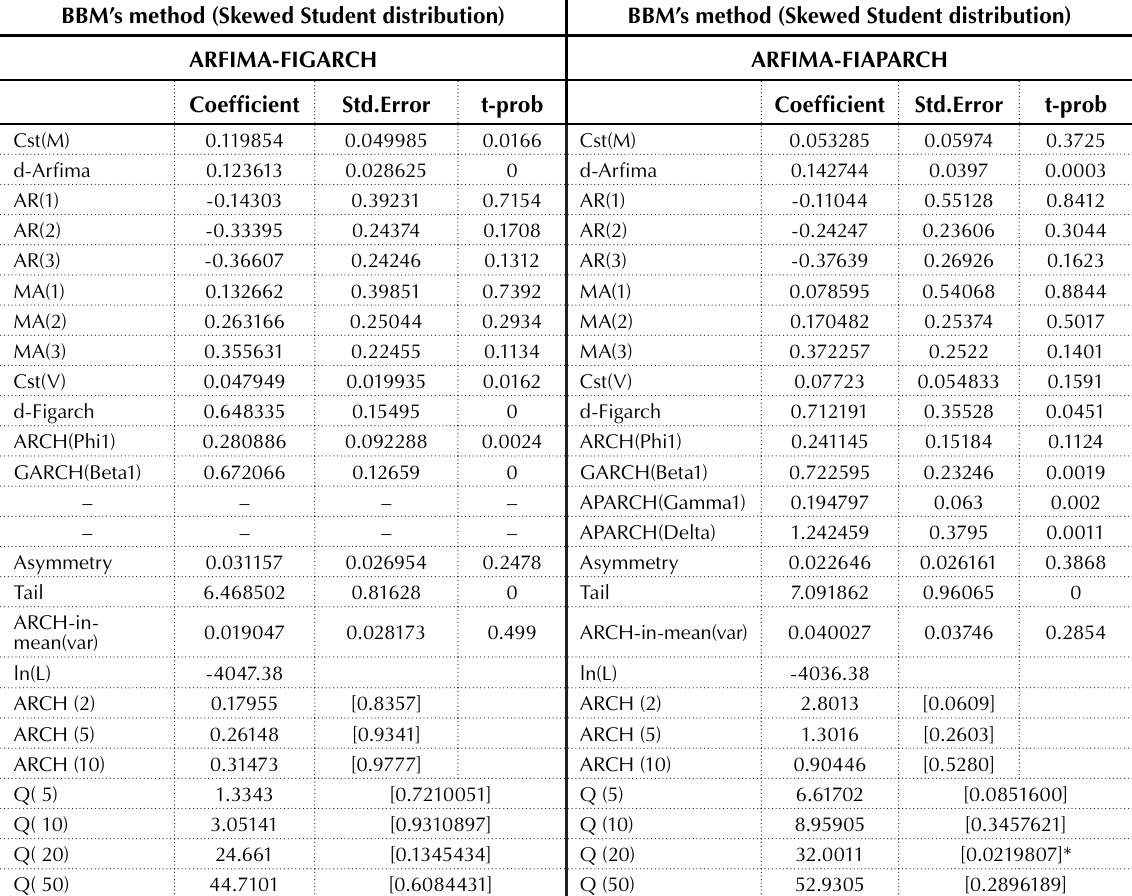
Source: compiled by